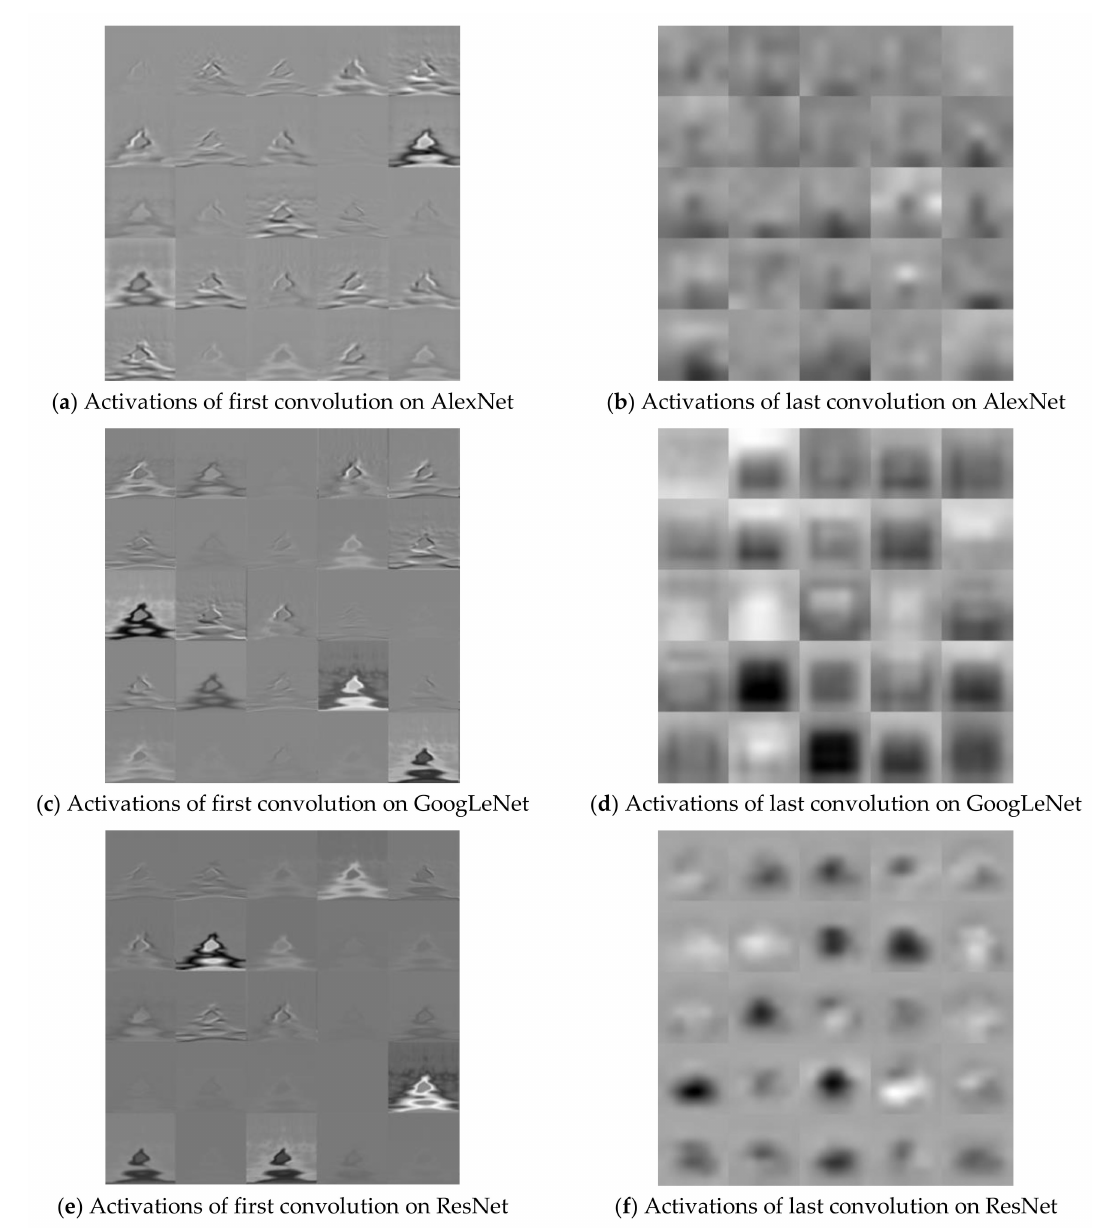
Figure 11. Comparison of the activations of the first and last convolutions in